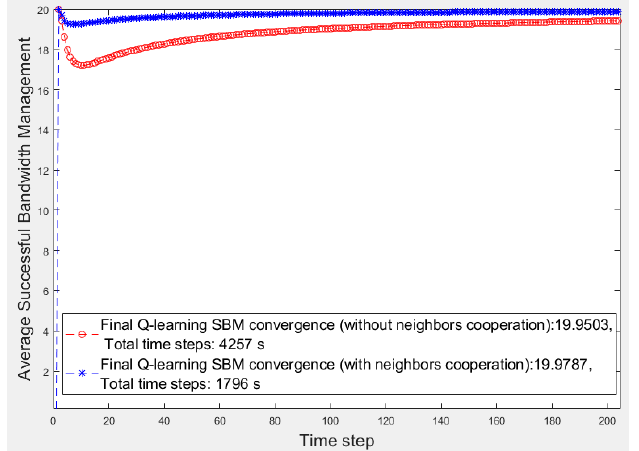
Figure 6. First 200 s of the average successful bandwidth management ( SBM ) of a five-fragment smart city network without and with fragment cooperation.